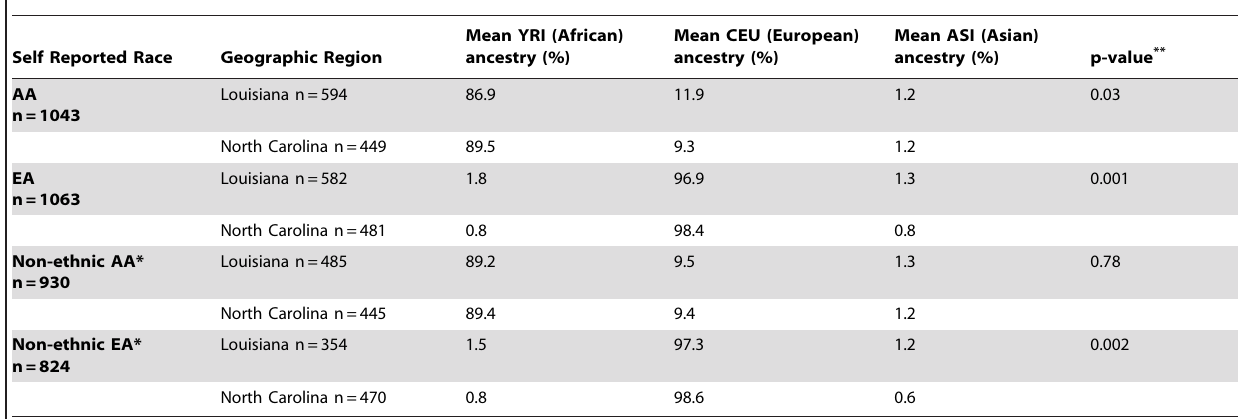
Table 1. Self-reported race and mean individual ancestry estimates by races and geographic region.